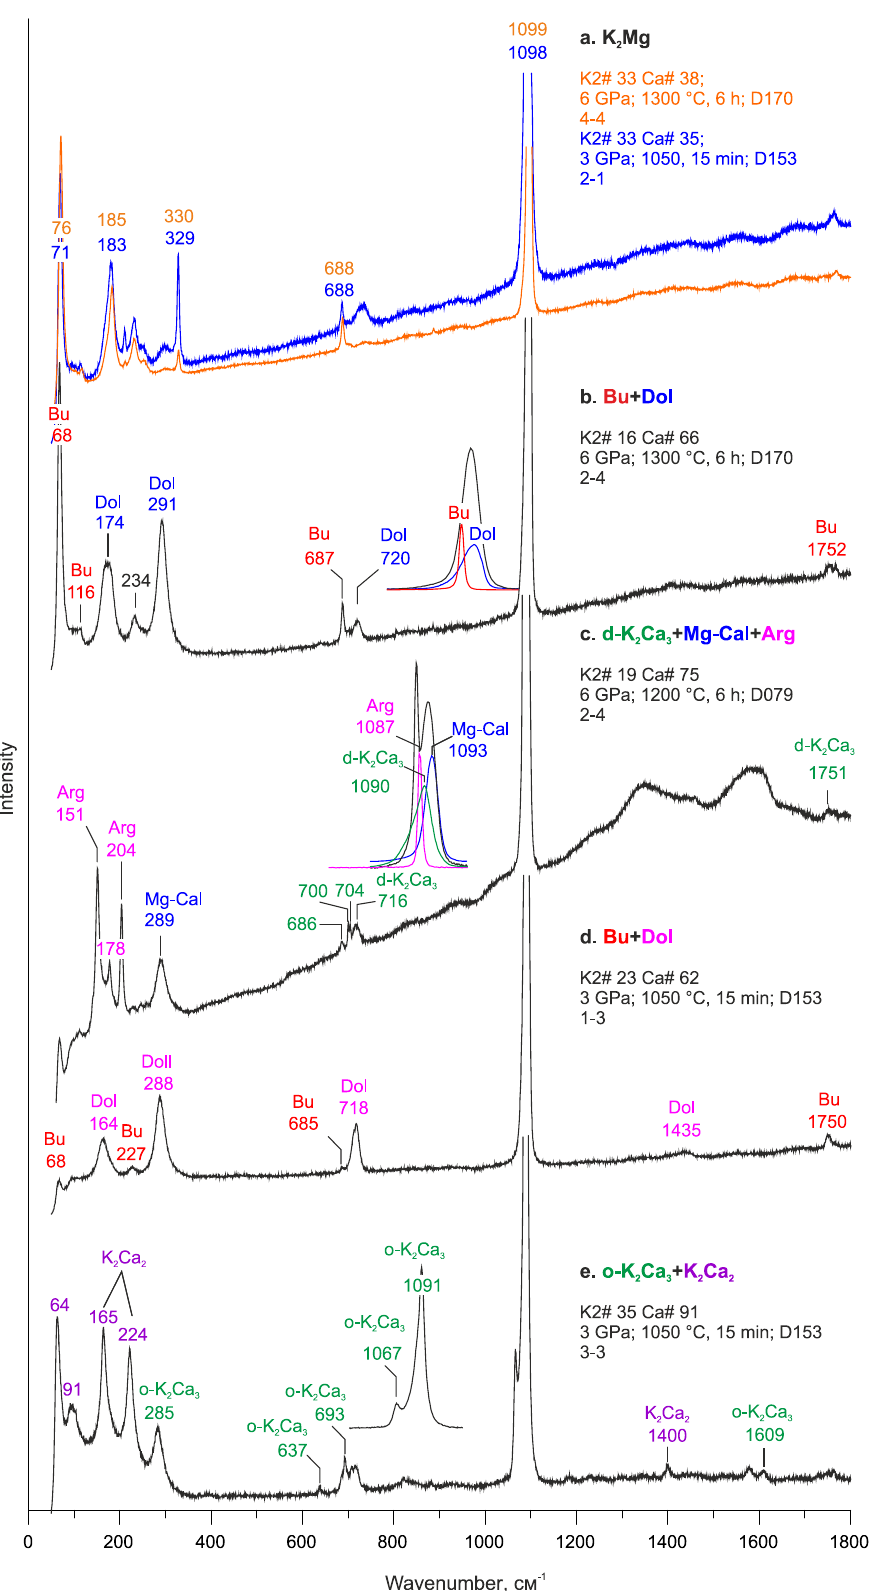
Figure 3. Raman spectra of quench products of the K 2 CO 3 -CaCO 3 -MgCO 3 melts at 3 and 6 GPa. Raman spectra were collected at ambient conditions.